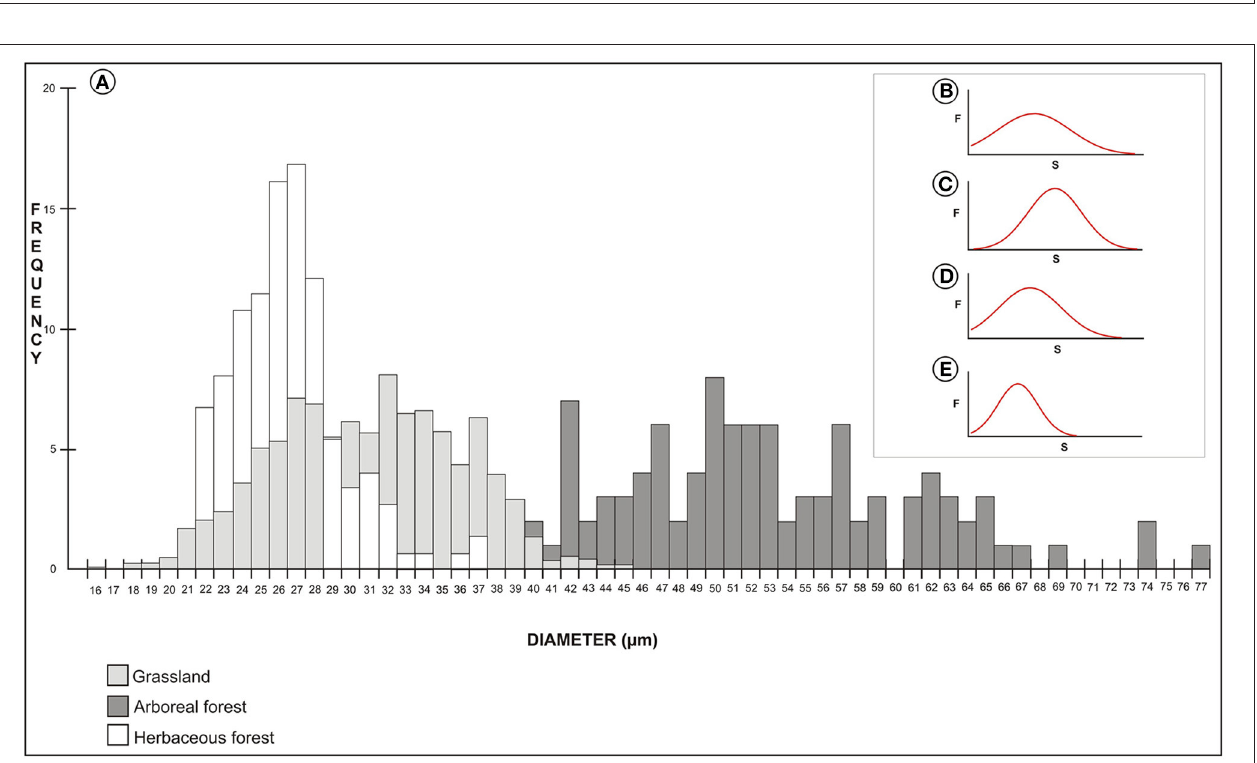
FIGURE 9 | Frequency distribution histogram of the pollen size measurements (A). Gaussian distribution of size measurements of pollen grains of arboreous species (B) , grassland species (C) , herbaceous forest species (D) , and all species studied (E) . F, frequency; S, pollen grain size.